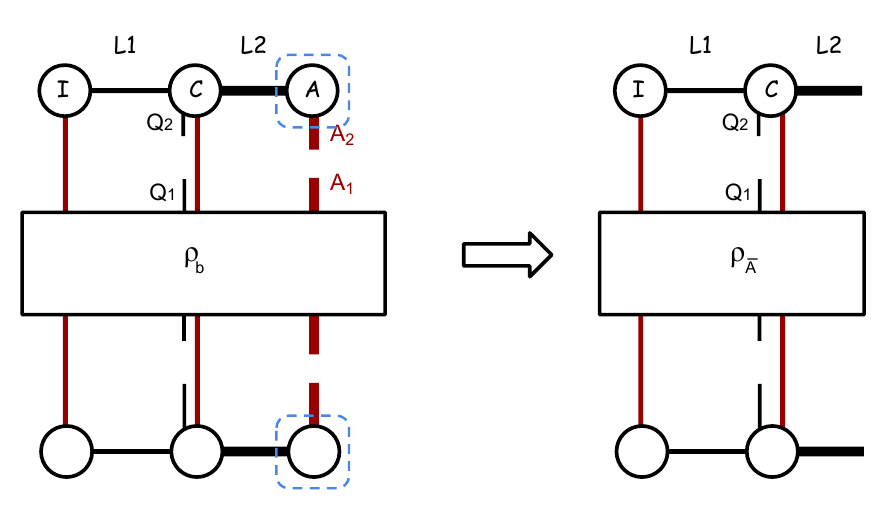
Figure 21. Illustration of a closed universe with a region A satisfying j A j > j L 2 j and no entangle- ment island. By cutting the network at L 2 = @A , the super-density operator of probe Q and region A can be decomposed to that of Q; A 1 ; L 2 conjugated by an isometry K A , de(cid:12)ned by the tensor(s) in the blue dashed region. The right panel illustrates the open universe obtained by removing K A part of the tensor network and tracing over A 1 to obtain (cid:26) = tr A ( (cid:26) b A